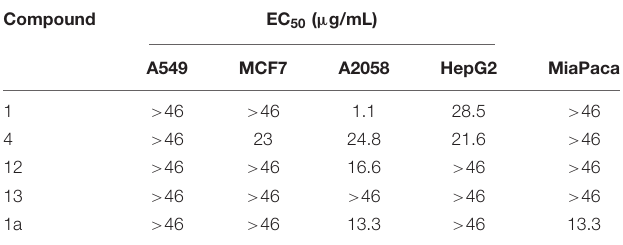
TABLE 2 | Cytotoxic activities of 1, 1a, 4, 12, and 13.